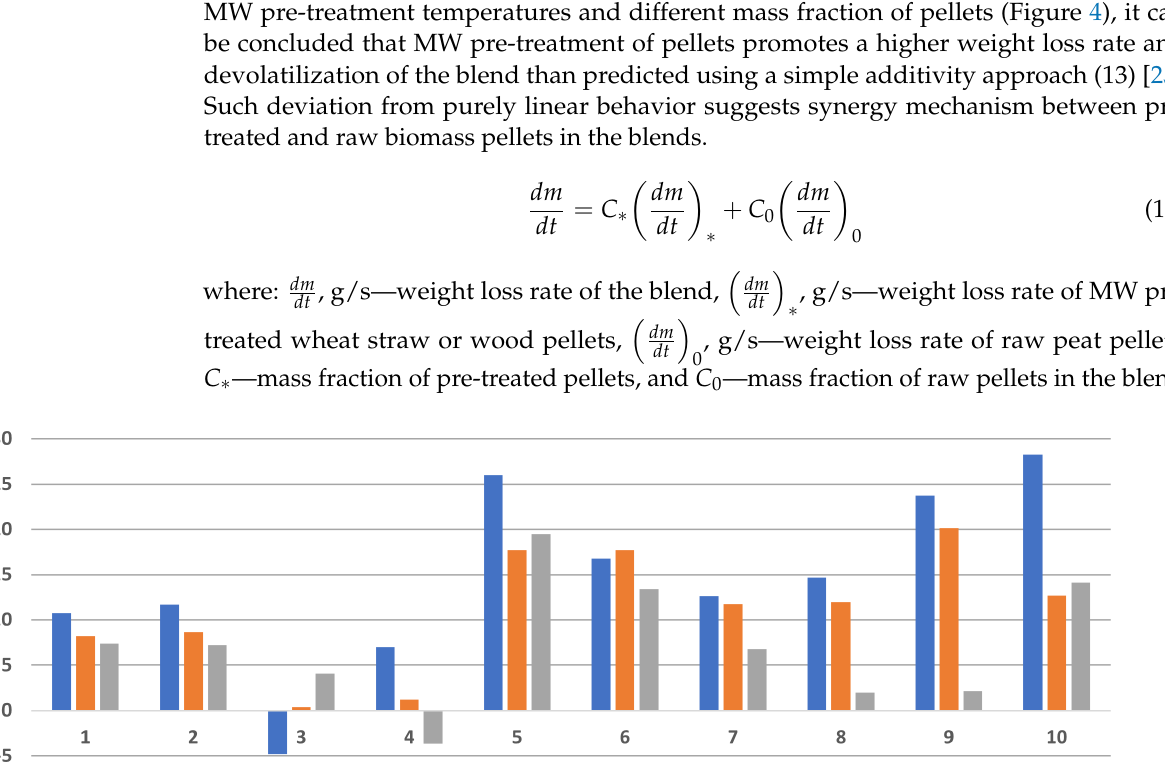
Figure 3. MW pre-treatment temperature effect on the weight loss rate for different blends ( a – e ) with fixed fraction of pre-treated pellets (30%).